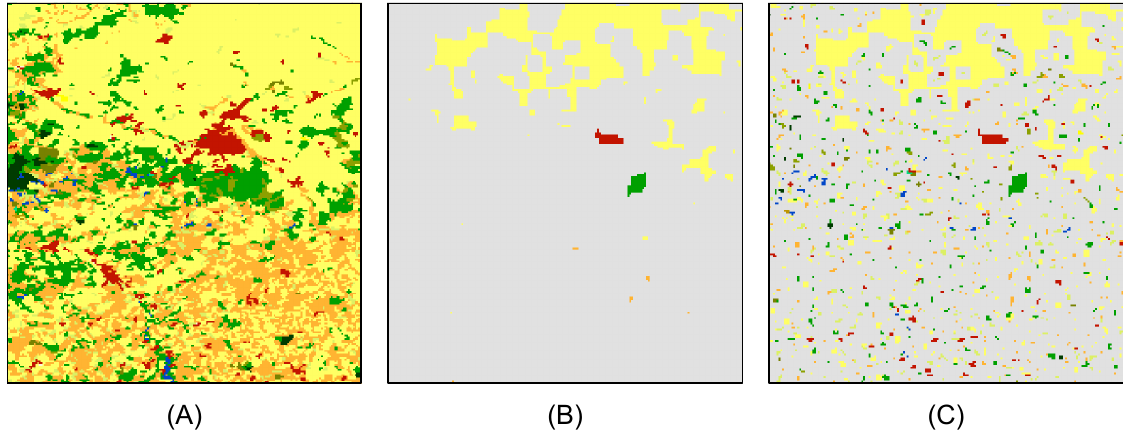
Figure 3. Results of the erosion filters for an area in Eurasia. The reference ( A ) shows a fragmented landscape that was nearly erased by the classical erosion ( B ), but the diversity of classes was maintained with the proposed multi-class border reduction filter ( C